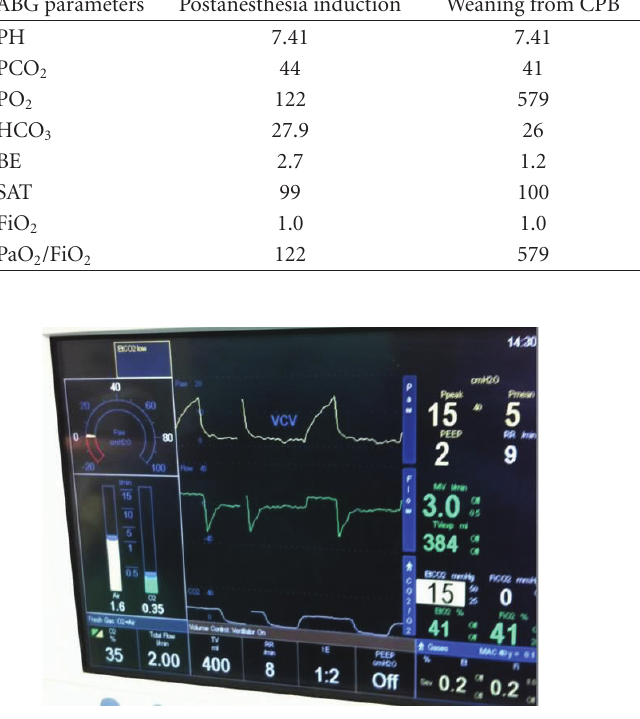
Figure 2: ETCO 2 during CPB.